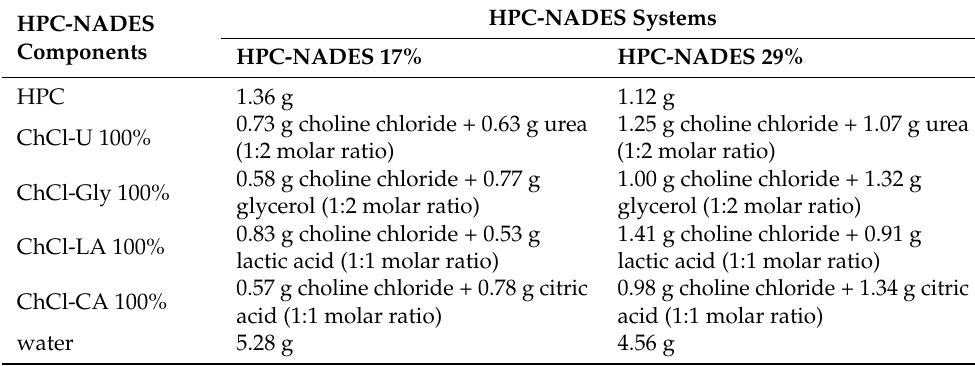
Table 7. The composition of the studied NADES and HPC-NADES